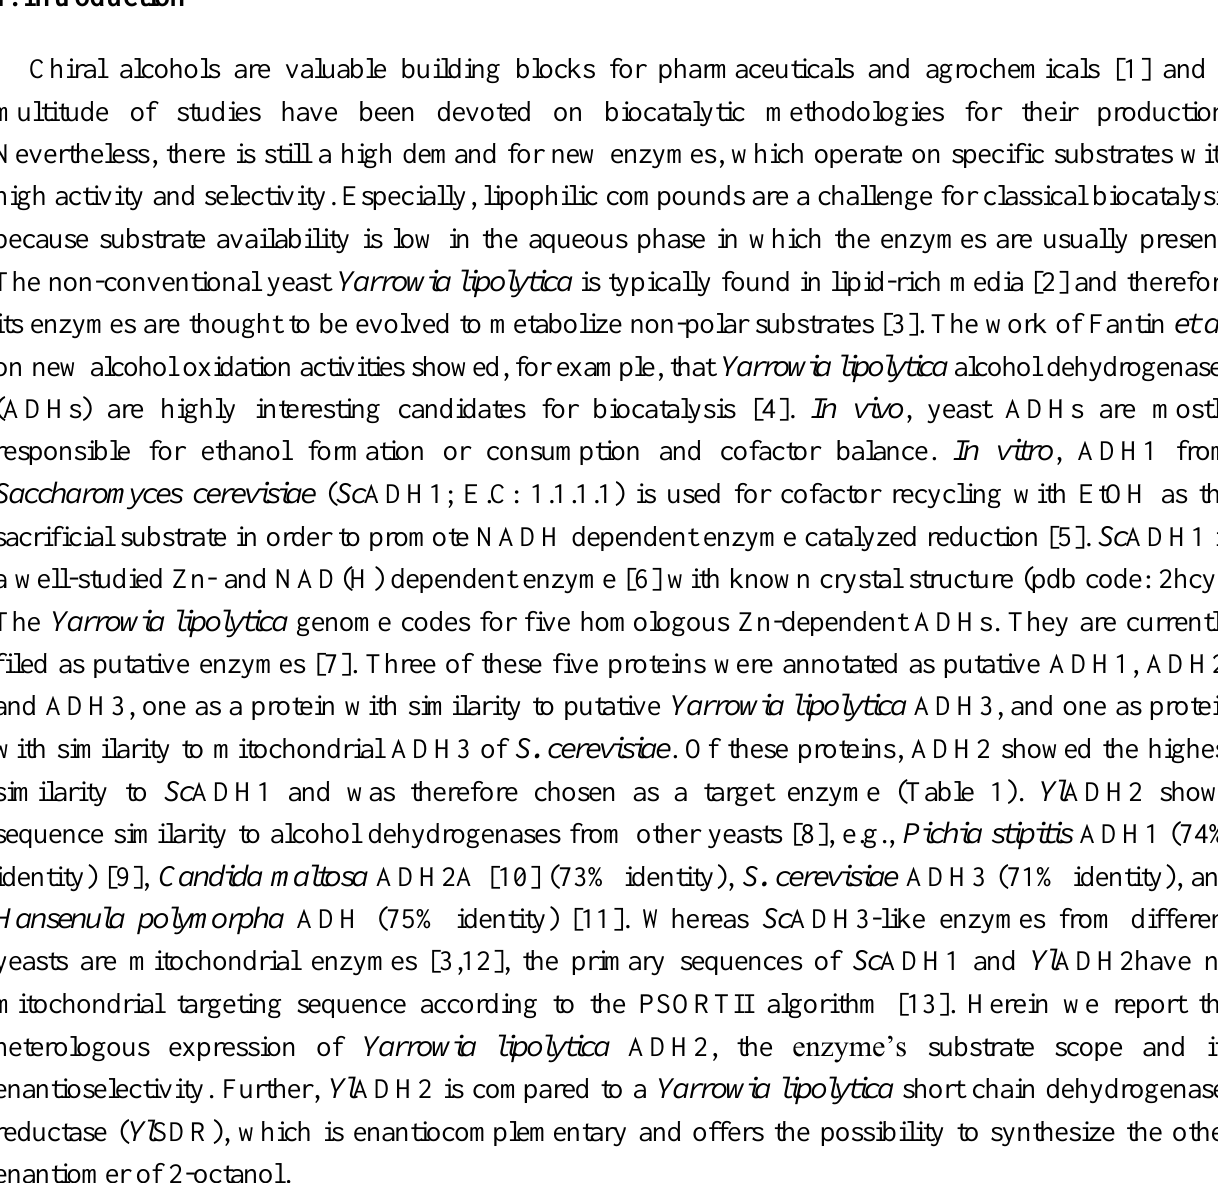
Table 1. Protein similarities of Saccharomyces cerevisiae ADH1 and Yarrowia lipolytica Zn-dependent ADHs. italics: Identities (%), bold: positives (%). Sc ADH1 Yl ADH1 Yl ADH2 Yl ADH3 Yl ADH Yl ADH Acc.